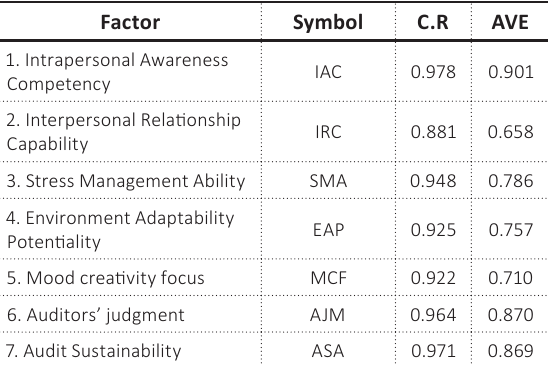
Table 4. Reliability and convergence value results